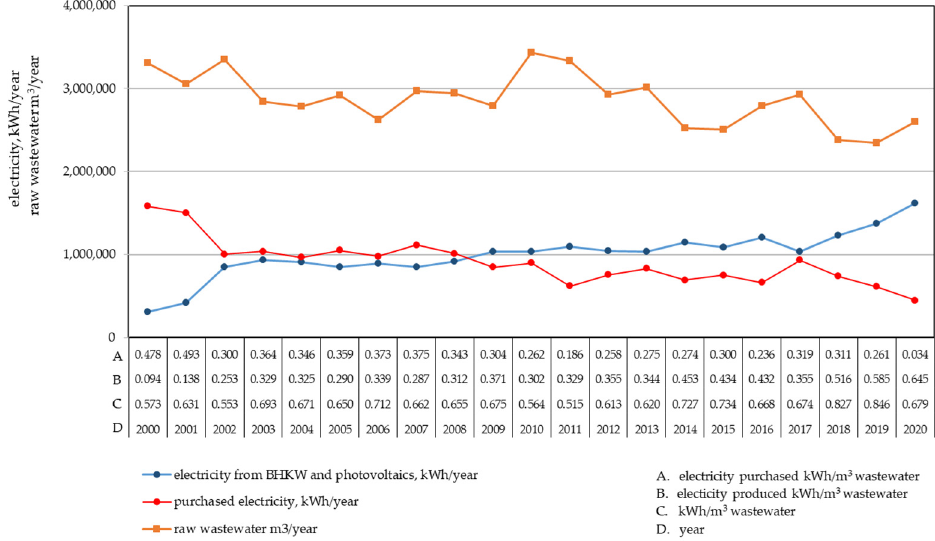
Figure 8. Amount of energy produced by BHKW and photovoltaic plant system, electricity purchased, and raw sewage in the years 2000 – 2020 .